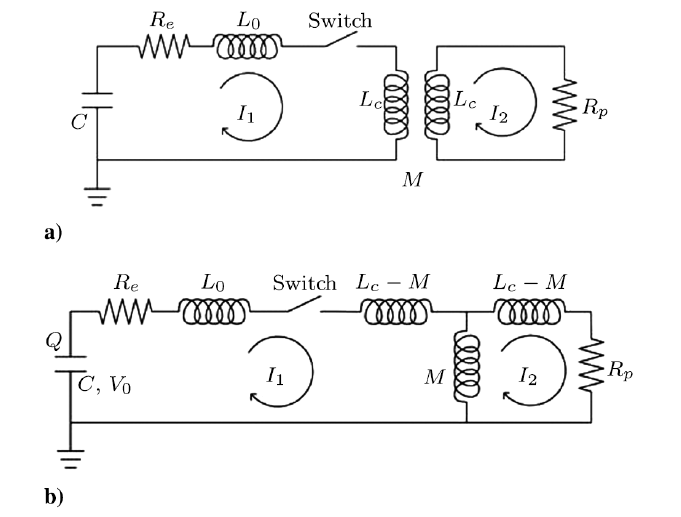
Figure 14. Circuit models: ( a ) general lumped-element representation of an IPPT and ( b ) equivalent circuit (after